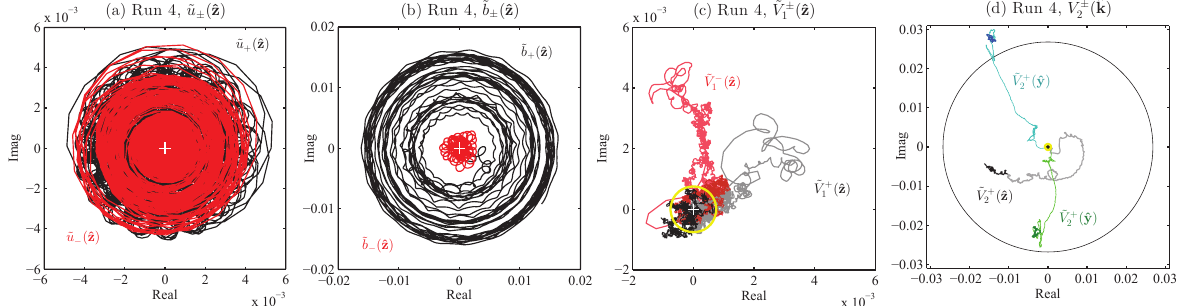
Figure 9. Phase portraits from Run 4; the white + marks the origin; the variables are normalized by ( ˆ z , t ) and ˜ b ( ˆ z , t ) before cyclic behaviors is N 3/2 , N = 128. Parts ( a , b ) show phase trajectories of ˜ u ± ± ( ˆ k , t ) trajectories when cyclicity is removed. In ( d ), stationarity removed. In ( c ) is an example of ˜ V ± 1 indicates coherent structure. The yellow circle in ( c ) indicates predicted average magnitude of each H avg variable; the large black circle in ( d ) has radius /3 = 0.0269, where Run 4 H avg is from M M (cid:113) ( ˆ z , t ) [ 0.23˜ b ( ˆ z , t ) + 0.97 ˜ u ( ˆ z , t )] , ˜ V ± ( ˆ x , t ) = ˜ b ( ˆ x , t ) , ˜ V ± ( ˆ y , t ) = ˜ b ( ˆ y , t ) Table 2. Here, ˜ V ± 2 2 1 ∼ ± ± ± ±